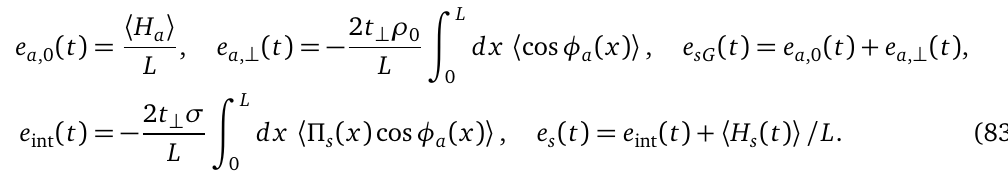
Figure 4: Variance of the relative phase, for σ = 0 (blue) and σ = 2 (red). A slight increase in the variance is visible for the larger value of σ for times below t